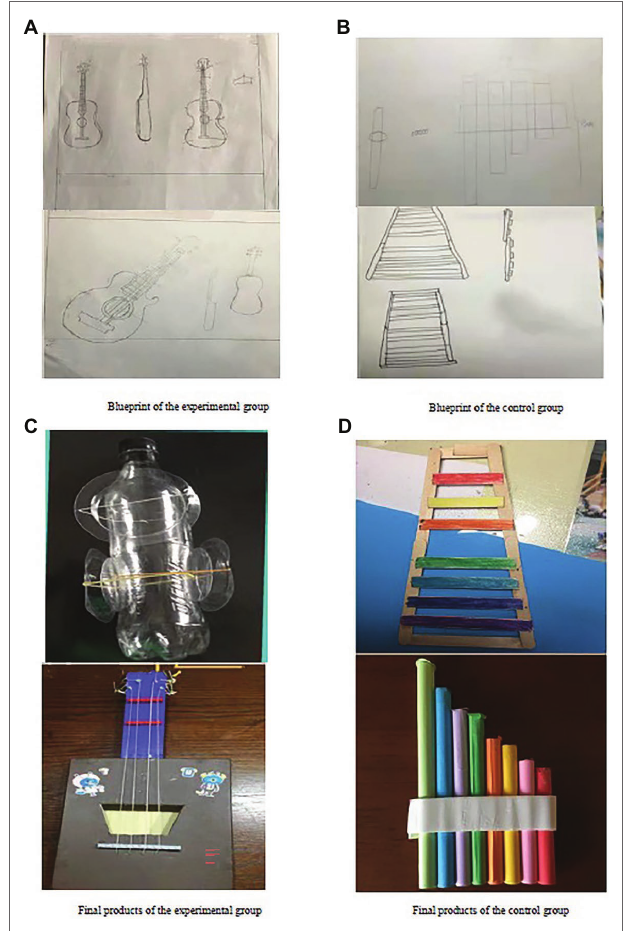
FIGURE 3 | Creative products (blueprint and the pictures of final products) from the experimental group and the control